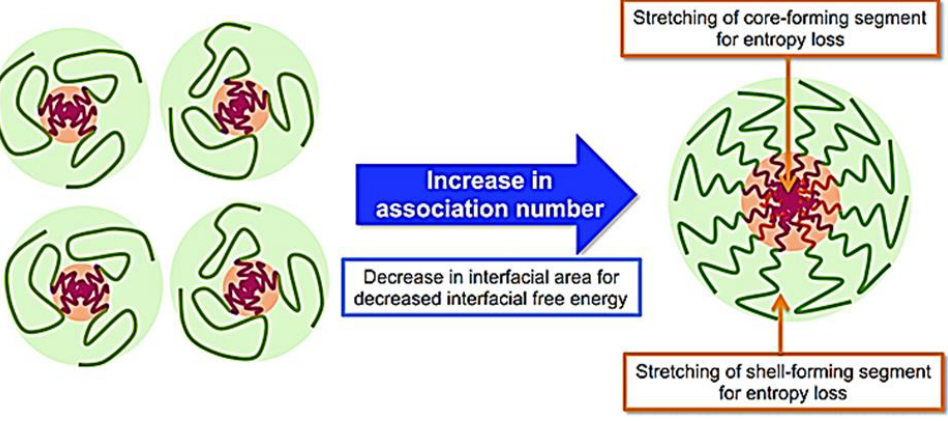
Figure 4. Mechanism of micelle formation from copolymers [37]. These bonds cause a decrease in the interfacial free energy of the system and a greater stabilization of the core. The micellization process is expressed in terms of free energy, CMT, and CMC (Equation (1)) as: